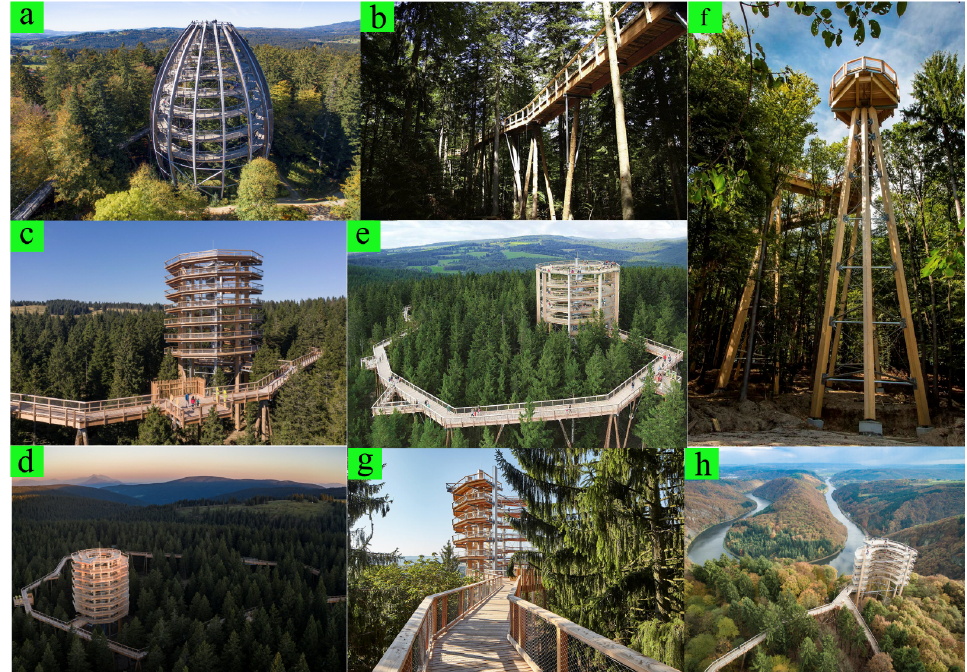
Figure A1. The treetop walkways in European countries built by die Erlebnis Akademie Ag (eak) of Germany (Source: https://www.baumwipfelpfade.de/nezr/nezr/, accessed on 25 July 2021). ( a , b ) The Bavarian Forest Treetop Walkway, Bavarian Forest National Park, Germany. ( c , e ) The Lipno Treetop Walkway, Lipno-Stausee Forest, The Czech Republic. ( d , f ) The Pohorje Treetop Walkway, the forests of the Pohorje, Republic of Slovenia. ( g , h ) The Saarschleife Treetop Walkway, Saar-Hunsrück Natural Park, Germany.